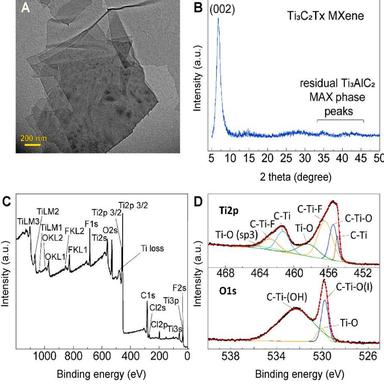
Characterization of Ti3C2Tx MXenes. (a) TEM images of stacked single-layer MXene films. (B–D) Phase composition and surface chemistry of Ti3C2Tx MXenes. Typical XRD profile (B), survey (C) and high-resolution (D) scans of Ti 2p and O 1s XPS spectra.